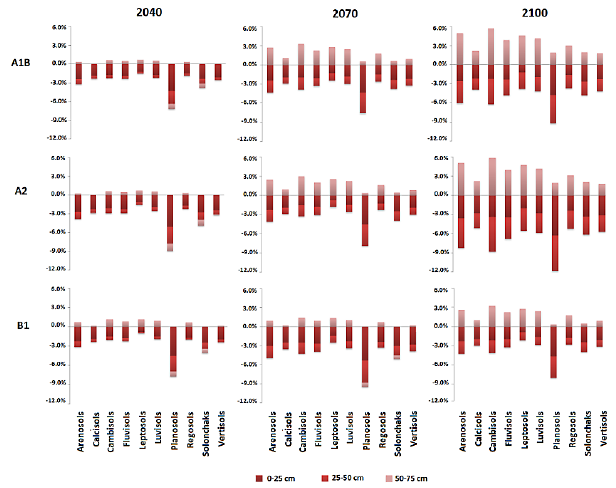
Fig. 6. Soil organic C stocks in climate change SRES scenarios in different periods (2040, 2070 and 2100) for each soil type at differ-